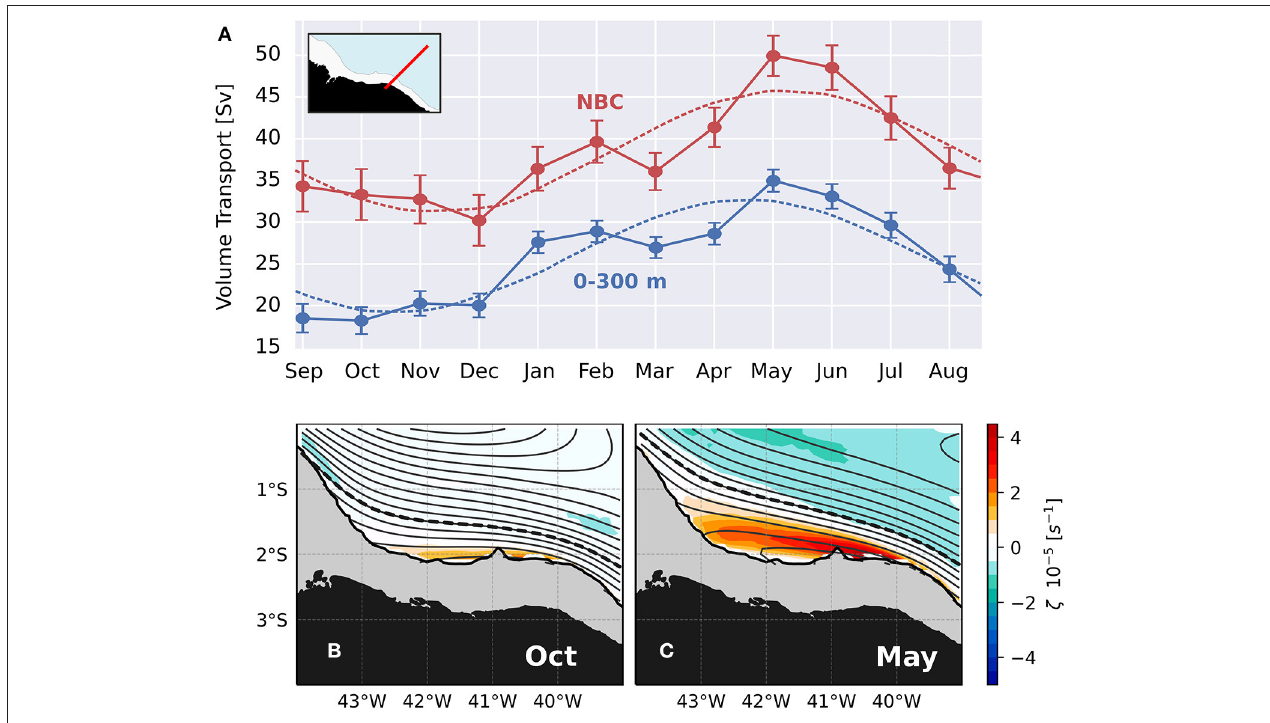
FIGURE 4 | (A) HR19.1 long-term mean volume transport and annual cycle (dashed) for the NBC upstream of the Barreirinhas Bight. October (B) and May (C) streamlines and vorticity mean fields for the first 300m. The dashed black line shows the NBC axis.